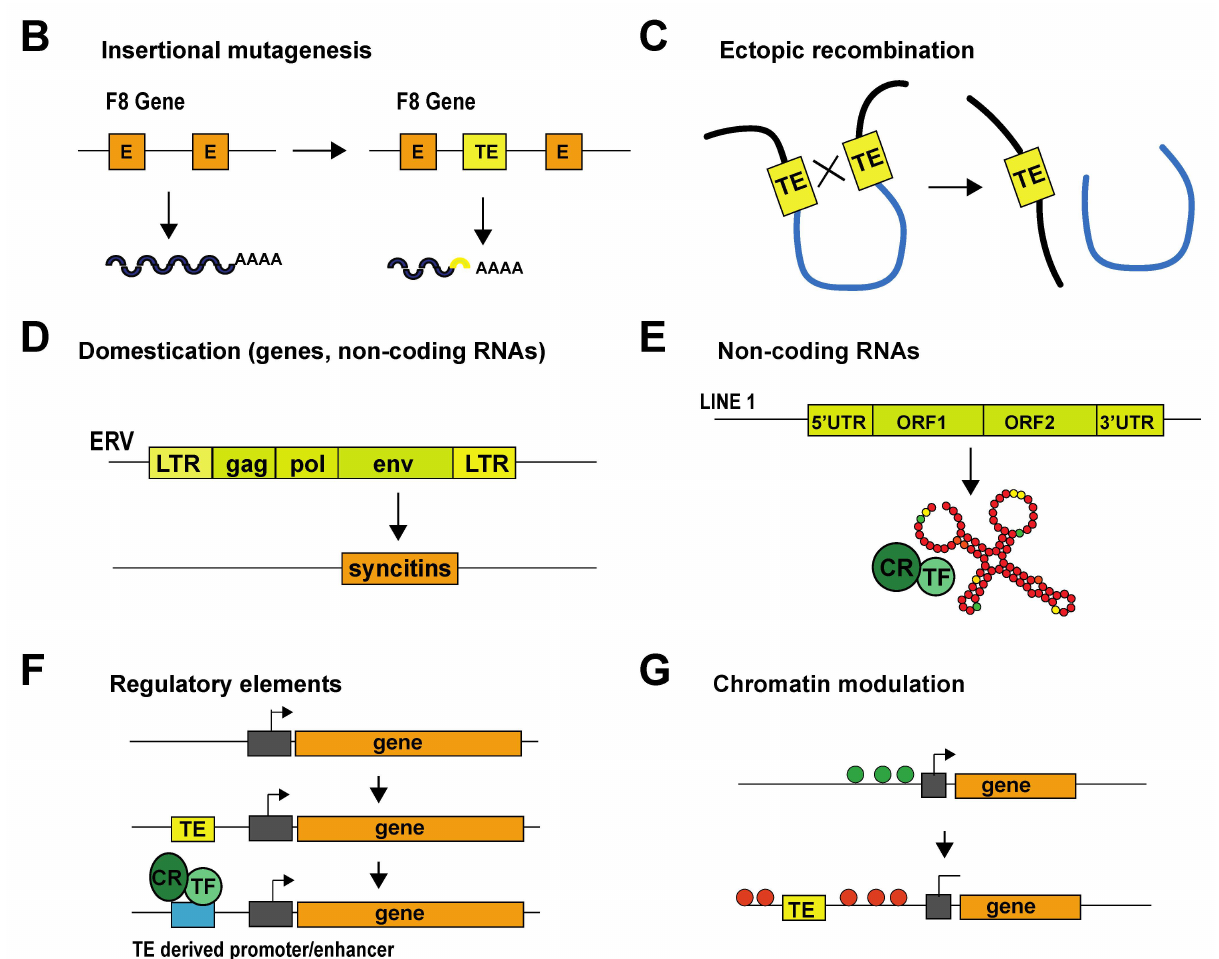
Figure 1. Impact of TEs on their host genome. ( A ) Examples of how TEs can impact genomes. ( B ) Schematic representation of a how insertion of a transposable element (TE) into the open reading frame of the coagulation factor VIII ( F8 ) gene can induce insertional mutagenesis. This mutation was found in patients with hemophilia [1]. ( C ) Schematic representation of TE-induced ectopic recombination. ( D ) An example of TE domestication. Ancient env genes from ERVs have evolved into syncytin genes, which are involved in placenta formation [8]. Another example not represented here is that of Rag1 and Rag2 , which are involved in V(D)J somatic recombination in the immune system of vertebrates [18]. ( E ) An example of a TE transcript (LINE1) acting as an RNA scaffold for chromatin regulators and transcription factors. ( F ) TE sequences carry transcription factor binding sites, and their insertion can lead to novel gene-regulatory patterns in the host organism. ( G ) Example of how a TE can modulate chromatin by inducing the spread of heterochromatin. Abbreviations: E, exon; TE, transposable element; LTR, long terminal repeat; ORF, open reading frame; UTR, untranslated region; CR, chromatin regulator; TF, transcription